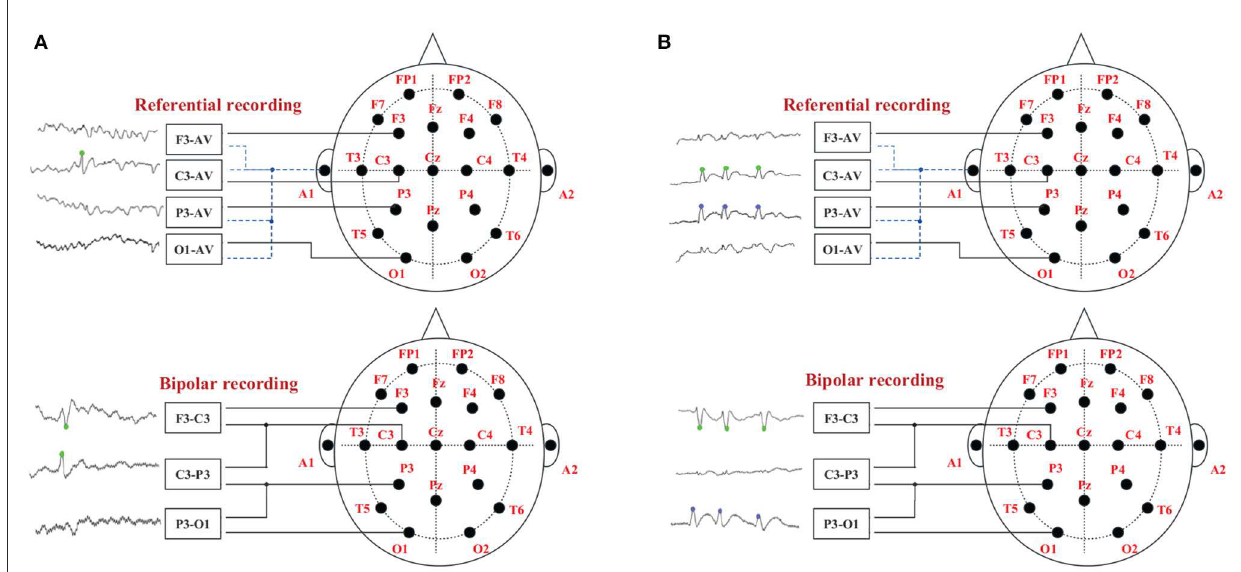
FIGURE2 The “peak-to-peak” phenomenon of different discharge modes. The green dots on the EEG signals indicate spike discharge in the C3 channel, and the blue dots indicate spike discharge in the P3 channel. (A) Single channel discharge. (B) Multiple channel discharge.